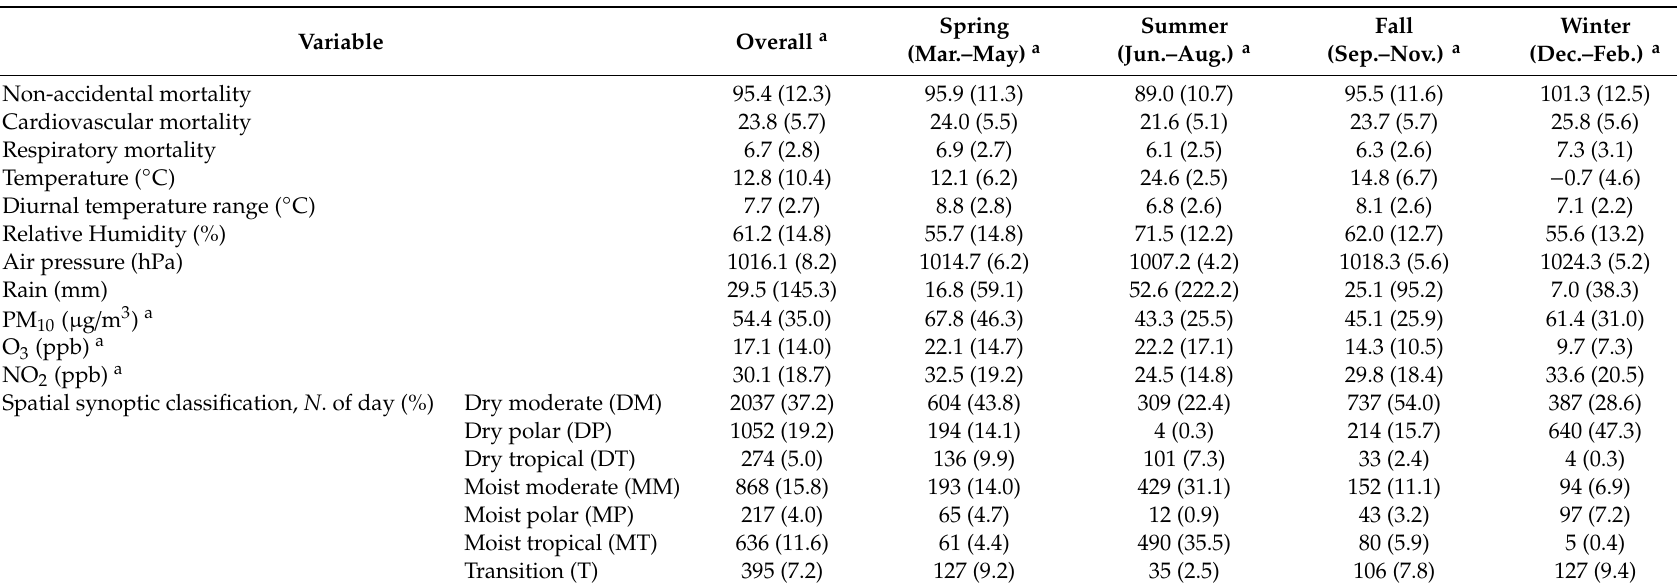
Table 1. Descriptive statistics for daily mortality and environmental variables in Seoul, South Korea,